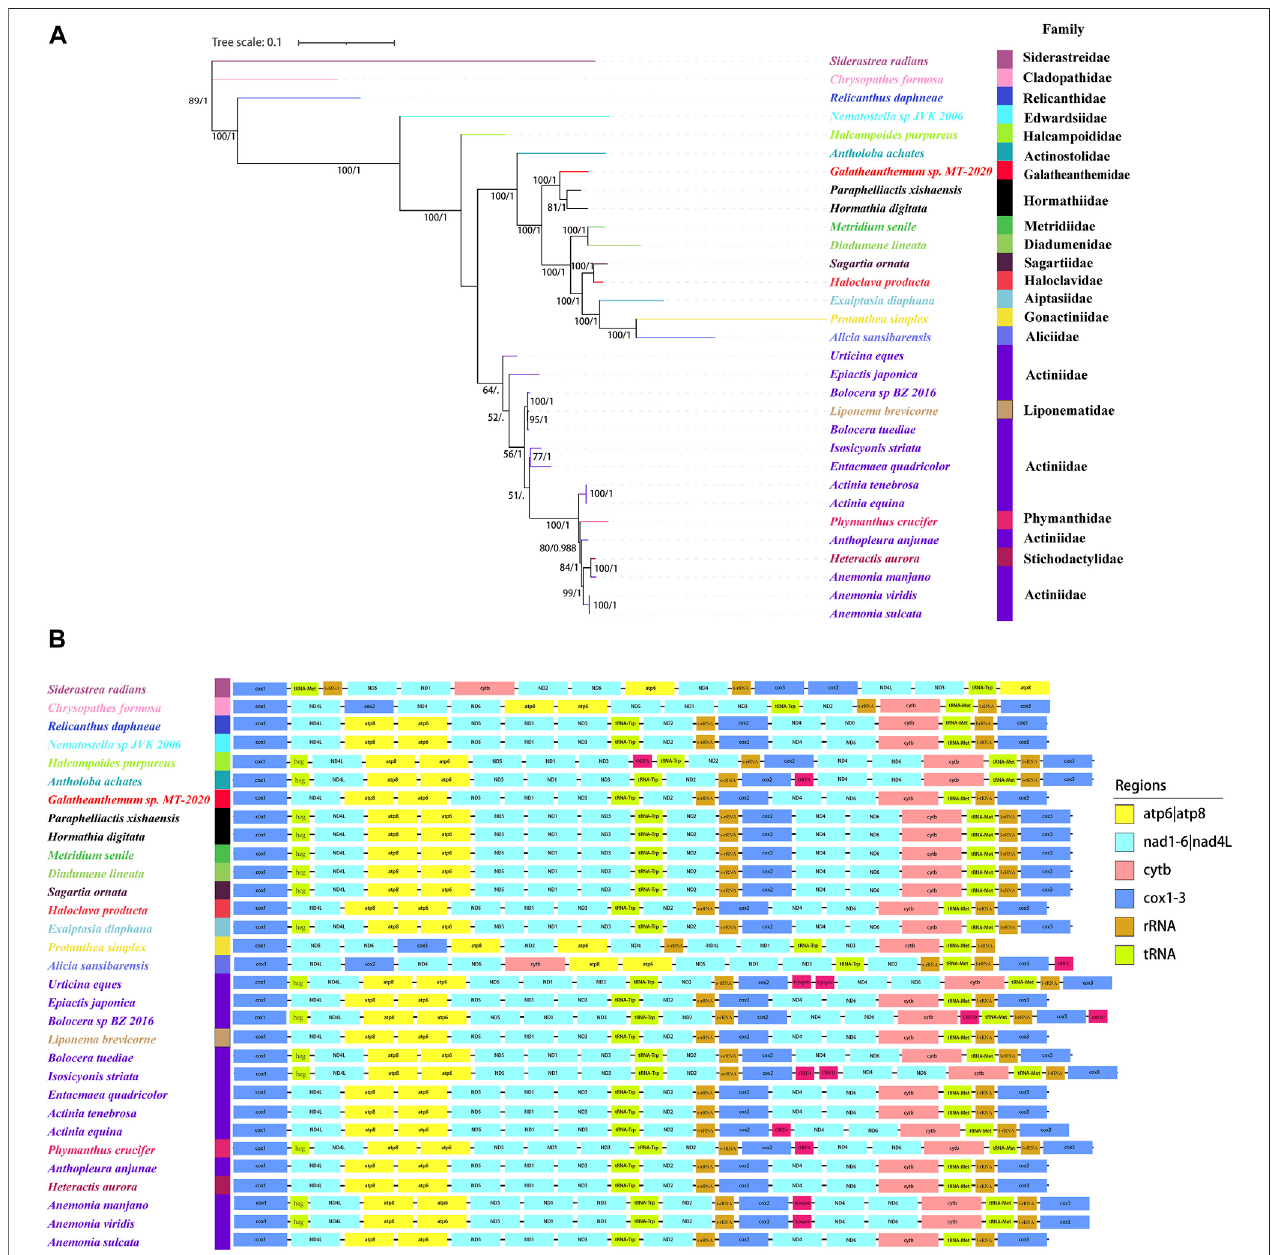
FIGURE 6 | The phylogenetic relationships and mitochondrial gene orders (A) The tree was constructed using 28 sea anemones based on the concatenated nucleotide sequences of 13 PCGs by Bayesian and maximum likelihood and showed by ML. Numbers on branches were Bootstrap values (left) and Bayesian posterior probabilities (right). The species examined in this study was labeled with star. (B) The gene orders of 28 sea anemones in mitochondrial were mapped, where genes encoded on the light strand are pre fi xed by minus sign. Different colors indicated different gene groups.